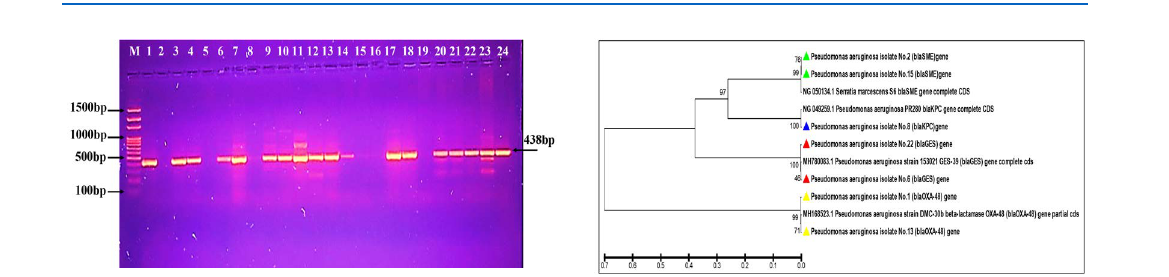
Fig. 6. Agarose gel electrophoresis of the bla (OXA- 48) gene the resistant P. aeruginosa isolates to carbapenem. M: ladder, 1500-100bp. Other lanes: positive amplification, 438bp